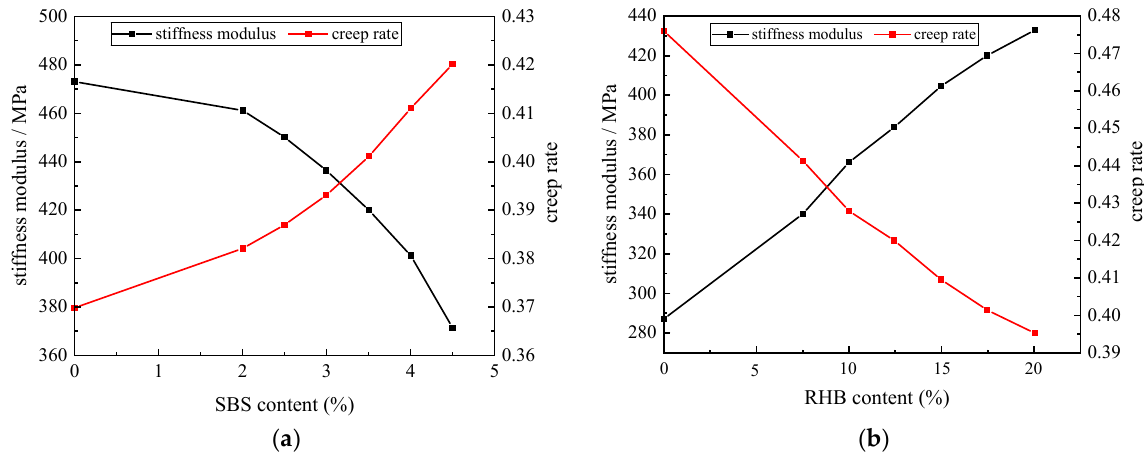
Figure 10. Curves of stiffness modulus and the creep rate of different composite-modified asphalt. ( a ) Composite-modified asphalt with fixed RHB content, ( b ) composite-modified asphalt with fixed RHB content.